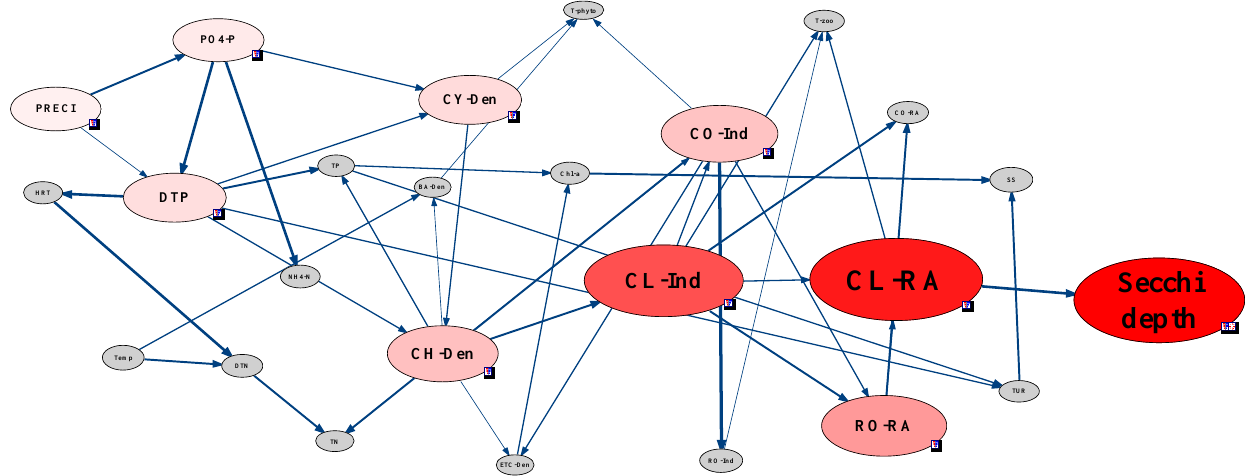
Figure 6. Sensitivity test and strength of influence analysis using the Bayesian network approach for assessing the CWP in St. 2, which was downstream of the Namhan River watershed. All data for St. 2 used in the Bayesian network were discretized using a hierarchical method and bin count 3.